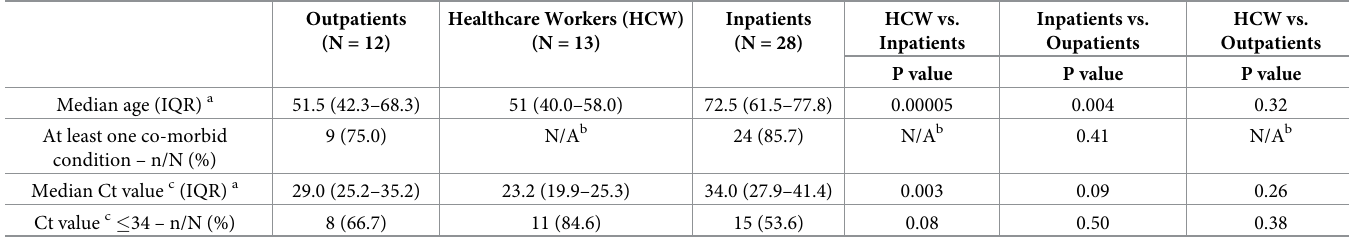
Table 1. Demographic characteristics and RT-PCR Cycle threshold (Ct) values of healthcare workers (HCW), inpatients, and outpatients.